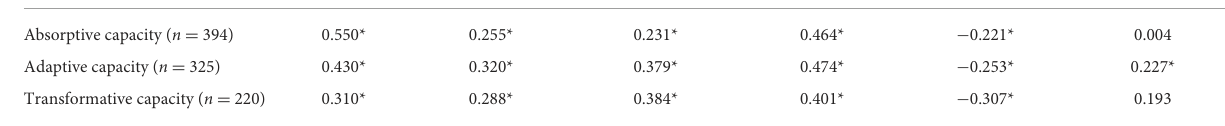
TABLE 3 Spearman’s correlation coefficients for assessing convergent and discriminant validity of the new